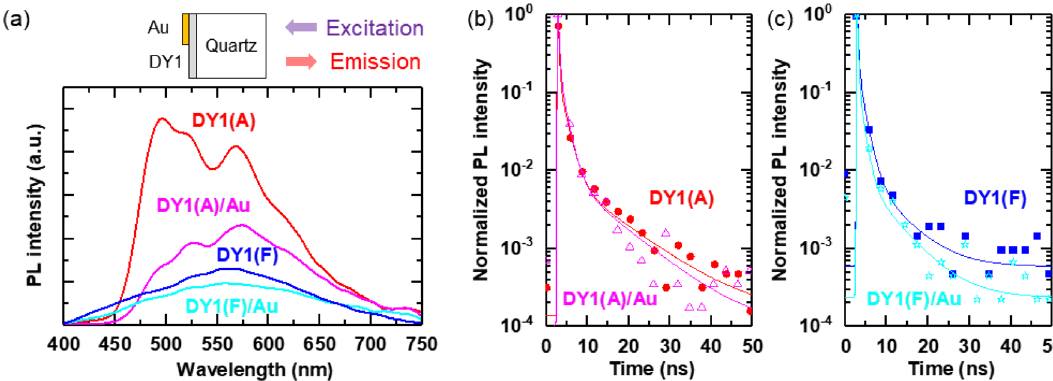
Figure 3. ( a ) Photoluminescence (PL) spectra of DY1(A), DY1(A)/Au, DY1(F), and DY1(F)/Au measured using a 375-nm excitation source with a beam diameter of ~ 1 μm. The measurement configuration is schematically illustrated above the spectra. ( b , c ) The time-resolved fluorescence decay curve of each region obtained from the fluorescence lifetime imaging microscopy (FLIM) images. Symbols and solid lines correspond to the raw data and least-square fitting, respectively. A 405-nm laser with a beam diameter of ~ 660 nm was used for the FLIM PL spectra of the DY1 assemblies/quartz samples were obtained under excitation at λ = 375 nm (Fig. 3a), of which the energy is comparable to E g of DY1 (3.38 eV) estimated from the STS data (Fig. 1c). The PL emission of the evaporated films of DY1 contains a multitude of bands that cover the entire visible region. The broad-band emission suggests that intermolecular species, such as aggregates, contribute to PL emission. The PL spectrum of DY1(A) contains the major peak at 500 nm and the minor peak at 570 nm. Both bands retain the vibronic structures and are bathochromically shifted from the monomeric emission (459 nm) of DY1 (“SI”, Fig. S2). These spectral behaviors exclude excimers as being responsible for the emission and suggest the presence of DY1 assemblies with varied stacking geometries. Notably, DY1(F) exhibits broad emission with a peak at λ = 570 nm. The relative decrease in the 500 nm emission of DY1(F) indicates the harvest of DY1 excitons by the low-energy assemblies. The Au thin film can work as a mirror to reflect incident and emitted light, which can increase the PL intensity from the Au-coated DY1. However, the PL intensity from the Au-coated region is smaller than that from the bare DY1 region (Fig. 3a). This suggests that the Au layer suppresses radiative decay in DY1. It can also be noted that the Au thin film modifies the relative intensity ratio of the major and minor bands in DY1(A), as shown in Fig. 3a and Fig. S7. If the major-band-relevant vibronic level is severely modified near the Au layer, then the major-band emission in the PL spectra can be reduced. Figure 3b,c shows that the Au thin film decreases the fluorescence lifetime of DY1(A) and DY1(F). The decreased lifetime by the Au layer is also clearly shown in the fluorescence lifetime imaging experiments (“SI”, Fig. S8a,b). The weighted lifetimes of DY1(F)/Au, DY1(F), DY1(A)/Au, and DY1(A) are estimated to be 1.2, 1.5, 1.7, and 2.3 ns, respectively (Fig. S8c). The interfacial charge transfer can suppress the radiative recombination of photogenerated excitons, leading to a decrease in the lifetime and PL intensity 23 . In addition, nonradiative energy transfer from excitons near the Au surface to surface plasmons can reduce the lifetime of the fluorescence emission 24 . Kelvin probe force microscopy (KPFM) enables measurements of the contact potential difference ( V CPD ) and V CPD ≡ [WF tip − WF sample ]/ e , where WF tip and WF sample are the work functions (WFs) of the KPFM tip and the sample, respectively, and e is the electron charge 25,26 . Figure 4a shows the surface morphology of the DY1(F) region partially coated with the Au thin film. The topographic image shows bumps on the surface, of which the typical height and lateral size are 10 nm and 2–300 nm, respectively. This suggests that the strong intermolecular interaction in DY1 leads to the generation of aggregates, as discussed above 4,5 . The height difference of the bare and Au-coated regions confirms the thickness of the Au thin film (60 nm). The V CPD maps measured on DY1 and Au are very uniform without topographic artifacts, as shown in Fig. 4b. The V CPD at DY1 ( V CPD,DY1 ) is smaller than that of Au ( V CPD,Au ) by 60 meV, and the WF of our DY1 layer should be slightly larger than that of ambient-exposed Au (4.5 ± 0.1 eV) 9 . Figure 4c shows that illumination with 405-nm light increases V CPD,DY1 . V CPD,Au should be kept constant since the Au layer was grounded. Thus, [ V CPD,DY1 − V CPD,Au ] clearly reveals a light-induced increase in V CPD,DY1 (Fig. 4d). V CPD,DY1 returns to the initial dark state value after turning off the light source, and hence, the reversible V CPD change should originate from the photogeneration of charge carriers. Figure 4e shows a schematic diagram of the energy levels of DY1 and Au before (left) and after (right) con- tact in the dark. Near the DY1-Au boundary, a Au layer with gradually varying thickness can be present due to incomplete blocking of the shadow mask. In the corresponding region, the V CPD continuously changes, as observed in Fig. 4b. The relative positions of HOMO and LUMO with respect to E F could be determined from the STS spectra (Fig. 1e): the LUMO and HOMO levels of DY1 are located at 1.40 eV above and 1.98 eV below E F , respectively. The WF (i.e., the separation between VL and the Fermi level) values of DY1 and Au were obtained from the KPFM-measured V CPD data. As discussed above, the VL shift at the DY1/Au interface, Δ , is supposed